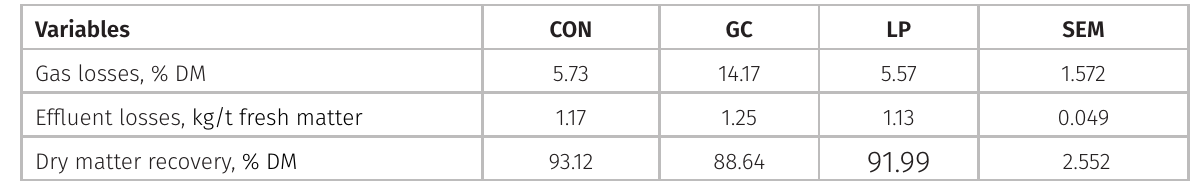
CON = Control; GC = Ground corn; LP = Lactobacillus plantarum (2.5 × 10 10 cfu/g) and Propionibacterium acidipropionici (2.5 × 10 10